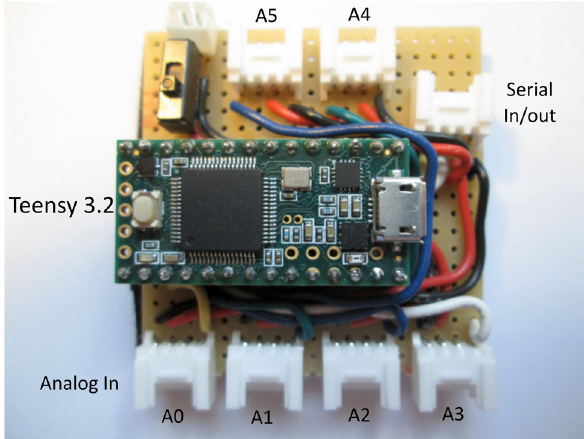
Figure 19: Teensy 3.2 board with analog